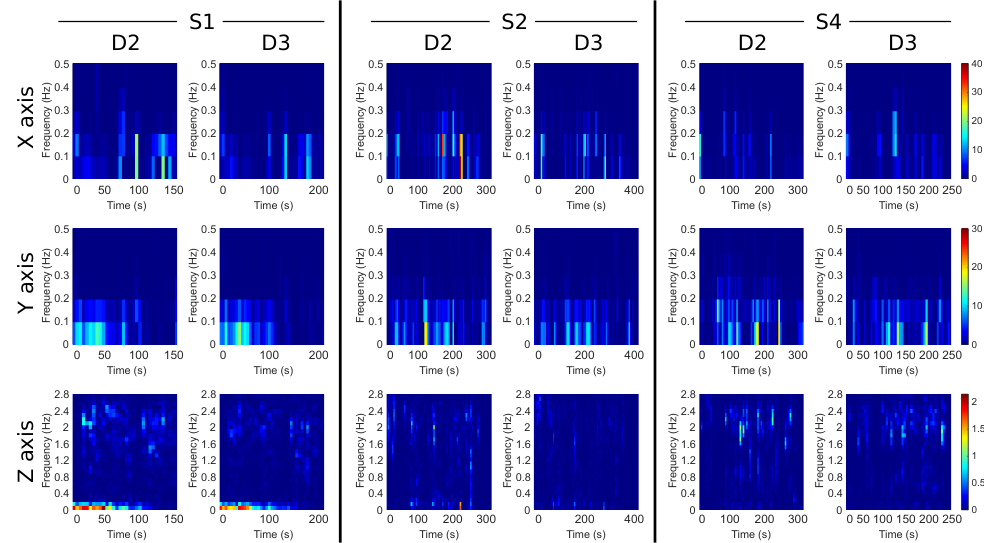
Figure 10. Spectrogram of the longitudinal ( x ), lateral ( y ) and vertical ( z ) axes (rows) of D2 and D3 drivers (columns) with C2 car when S1, S2 and S4 sections are considered (blocks).